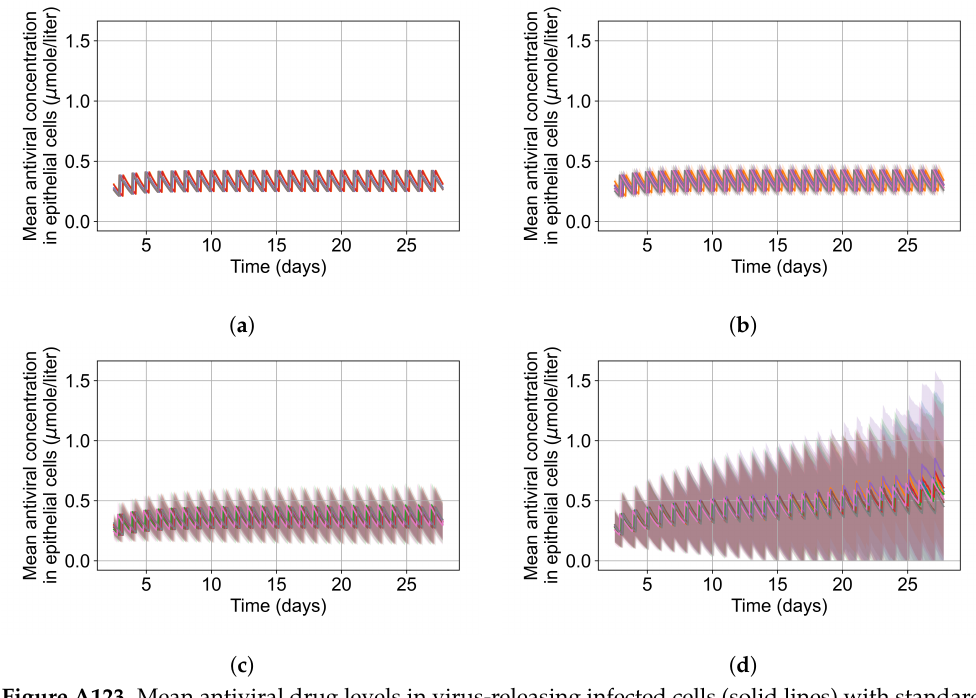
Figure A123. Mean antiviral drug levels in virus-releasing infected cells (solid lines) with standard deviation (shaded regions) versus time for individual simulation replicates under different simulation options. ( a ) is treated with no metabolism heterogeneity, ( b ) is treated with a metabolism standard deviation of 0.1, ( c ) is treated with a metabolism standard deviation of 0.25, and ( d ) is treated with a metabolism standard deviation of